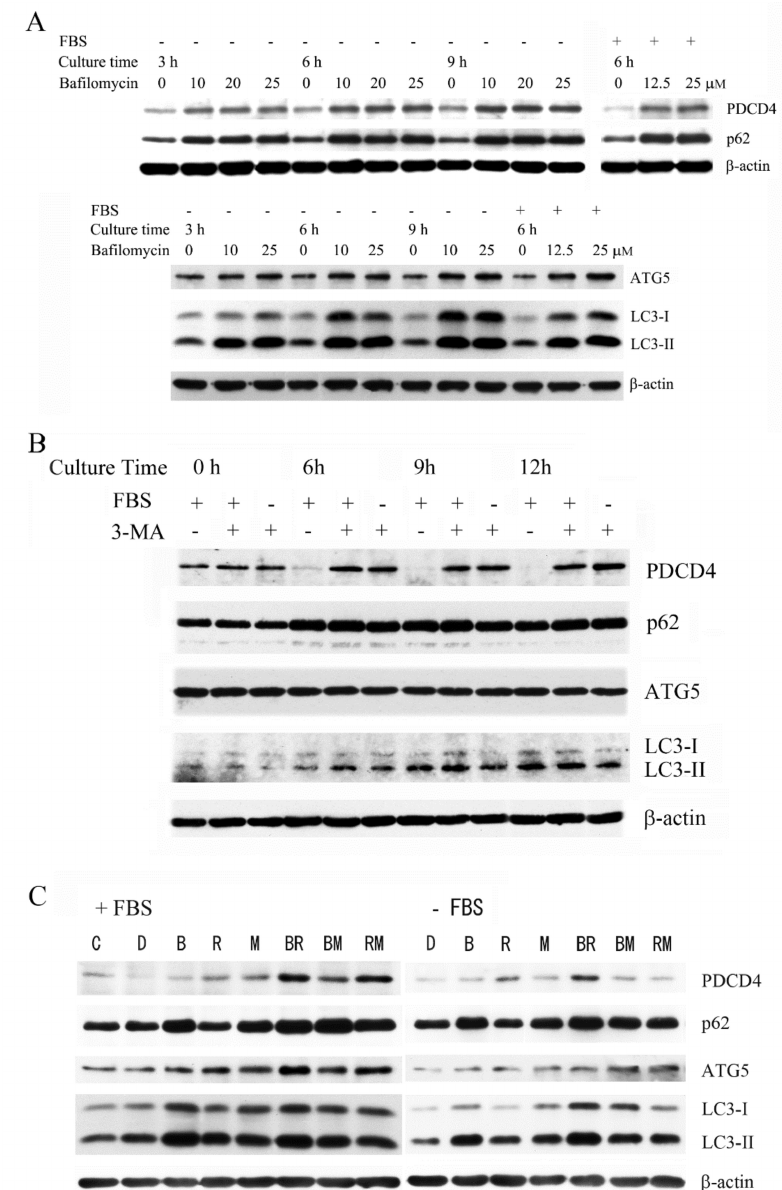
Figure 2. Both autophagy and proteasome inhibitors upregulated the PDCD4 levels. ( A ) After culturing for 4 days, Huh7 cells were treated with di ff erent concentrations of bafilomycin A1 as indicated in the figure, in the presence or absence of FBS for 3, 6, and 9 h. Western blotting was performed using antibodies against the components mentioned in the figure. The same sample was used to identify the components indicated in both the upper and lower panels. ( B ) Approximately 3 × 10 5 Huh7 cells were cultured in a 35-mm dish in normal medium. At 90%–95% confluency, the medium was replaced with a medium either with or without FBS. The cells were treated with 5 mM 3-methyl adenine (3-MA) and collected after 6, 9, and 12 h for Western blotting. For analyses at 0 h, the cells were collected immediately after treatment ( < 15 min). ( C ) After culturing for 4 days Huh7 cells were treated with 10 µ M bafilomycin A1 (B), 0.1 nM rapamycin (R), 20 µ M MG132 (M), the combination of bafilomycin A1 and rapamycin (BR), bafilomycin A1 and MG132 (BM), rapamycin and MG132 (RM), and DMSO (D) as a control. After 4 h of treatment, the cells were collected for Western blotting. Experiments were repeated more than three times and similar results were obtained consistently in each case. representative results are